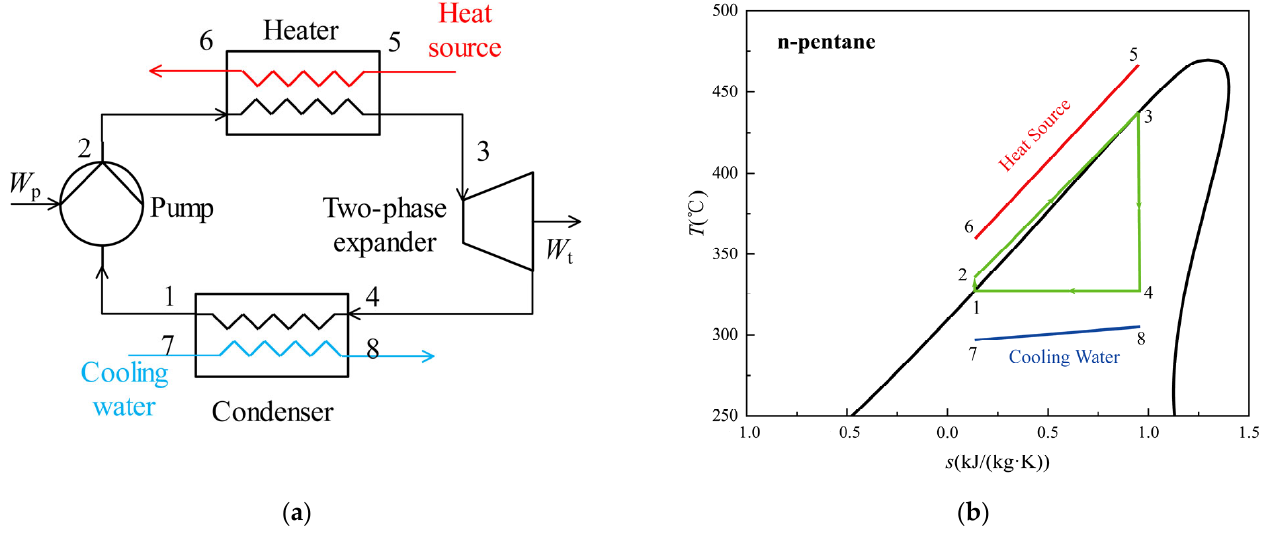
Figure 1. Schematic diagram ( a ) and temperature ‐ enthalpy diagram ( b ) of the TC